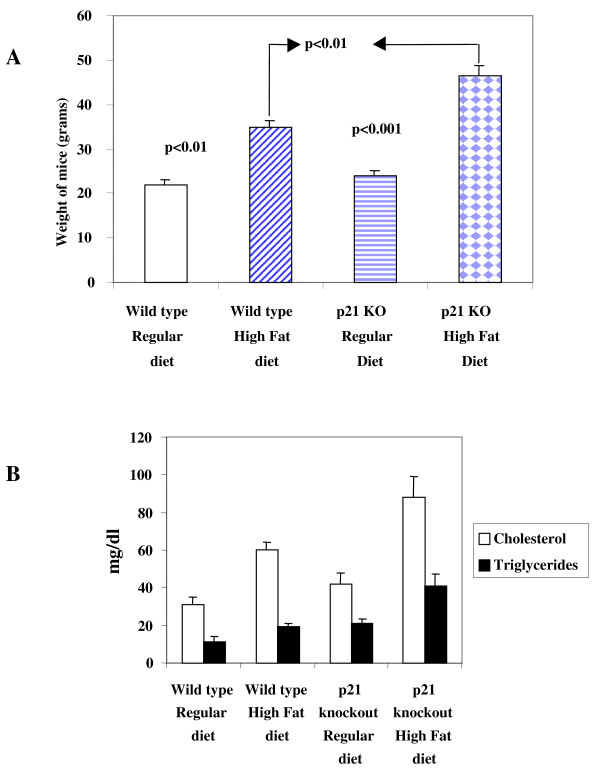
Body weight (BW), plasma cholesterol, and plasma triglyceride levels in p21-/- and wild type control mice. A: Differential effect of high fat diet on weight gain in wild type mice (n = 8) and p21-/- (n = 8) mice is shown. Values are means ± SEM, Weight gain in p21-/- mice fed with high fat diet is compared to p21-/- mice fed with regular diet and wild type mice fed with high fat diet. B: Differential effect on the effect of high fat diet on plasma levels of cholesterol (open bars) and triglycerides (closed bars) in p21-/- and wild type mice fed with high fat and regular diet is shown.